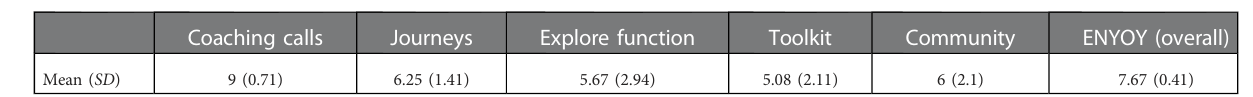
TABLE 4 Average perceived helpfulness scores of the components of ENYOY on a 1 – 10